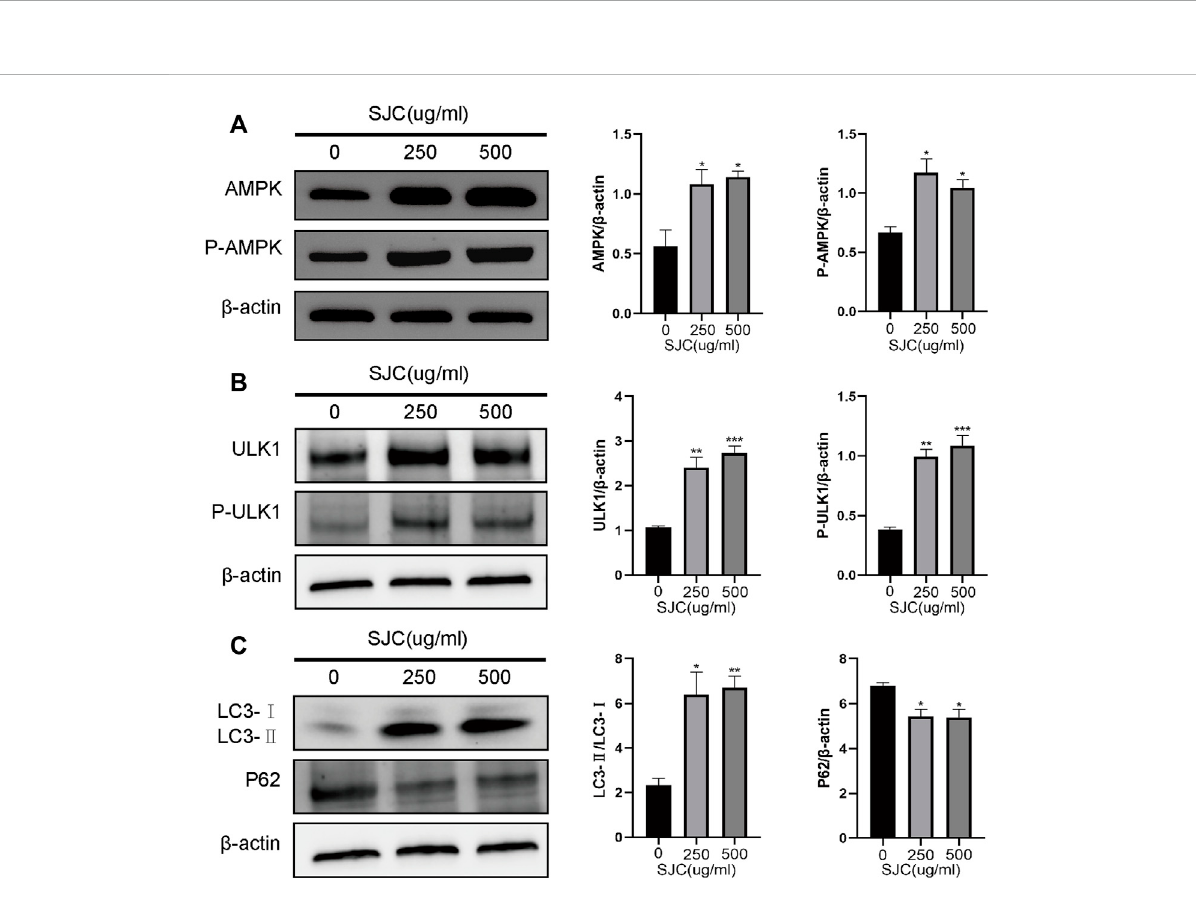
FIGURE 6 DifferencesinexpressionofAMPK-ULK1signalingpathwayandkeyproteinsinautophagyinthecontrolgroup,andthe250and500 μ g/mlSJC groupsdetectedbyWesternblotting. (A) TheexpressionofAMPKandP-AMPKincreasedafterSJCtreatment. (B) TheexpressionofULK1andP-ULK1 increased after SJC treatment. (C) The ratio of LC3- Ⅰ to LC3- Ⅱ was enhanced after SJC treatment. ImageJ software was used to calculate the band intensity. The experiments were repeated three times independently. The data were expressed as mean + SEM,* p < 0.05, ** p < 0.01, *** p < 0.001, **** p < 0.0001 vs.